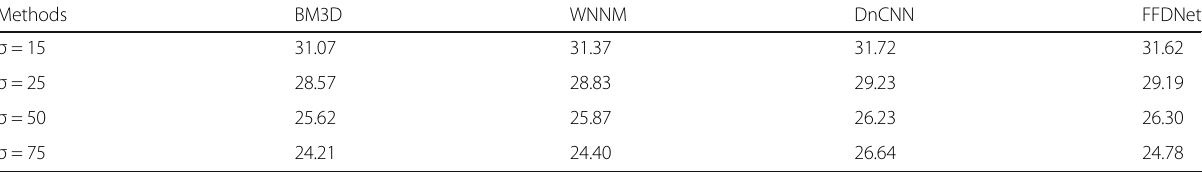
Table 1 Average peak signal-to-noise ratio (dB) results for different methods on BSD68 with noise levels of 15, 25, 50 and 75 Methods